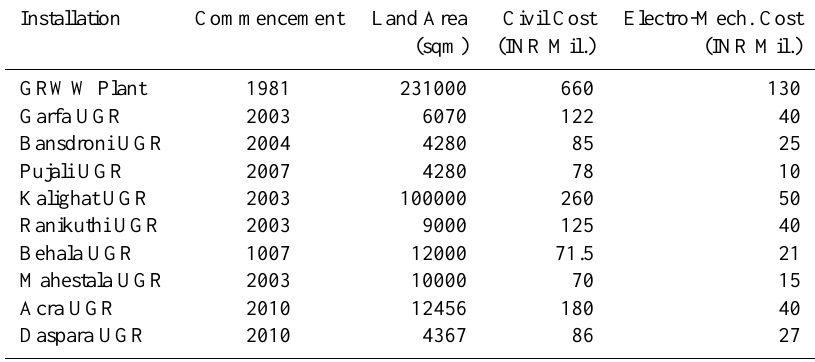
Table 2. Details of capital costs.